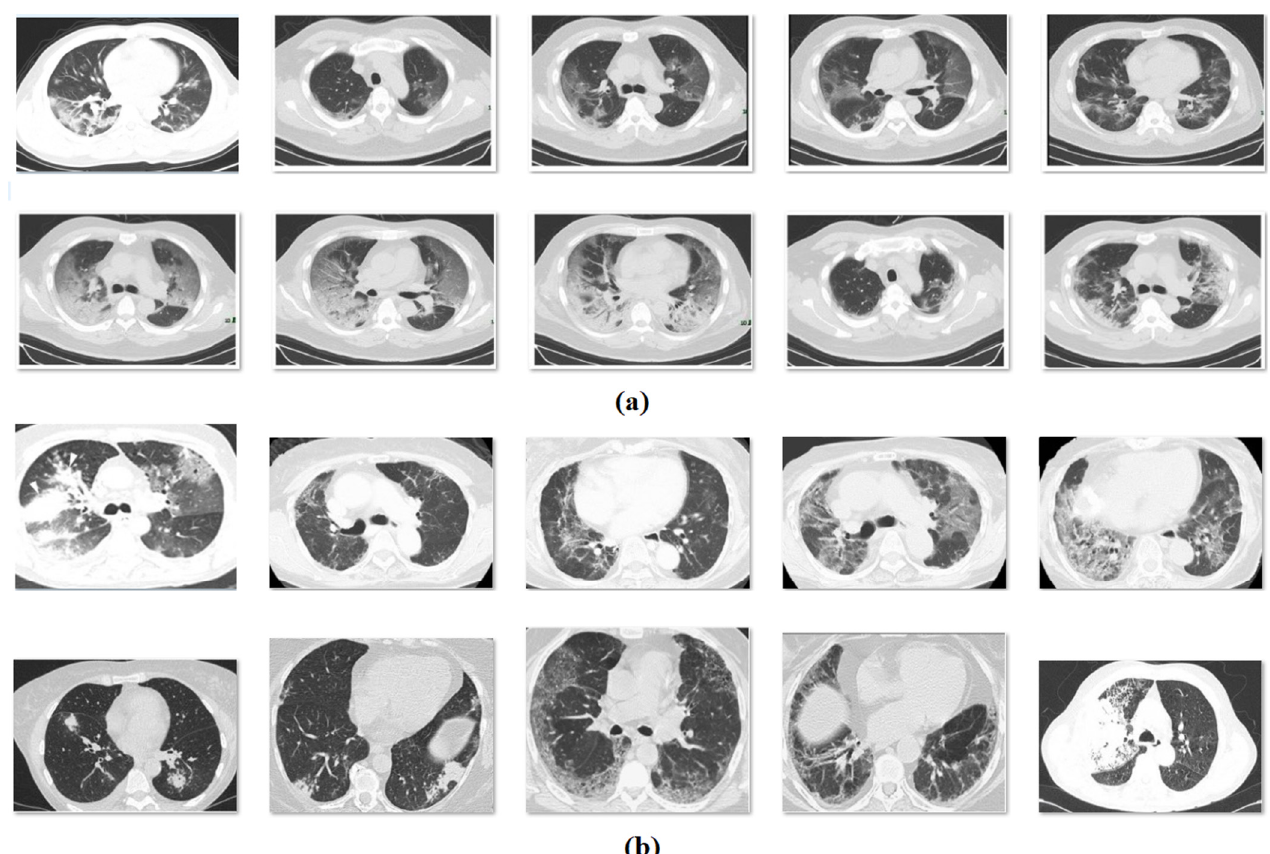
Figure 3. ( a ) COVID, ( b ) non-COVID: sample images.